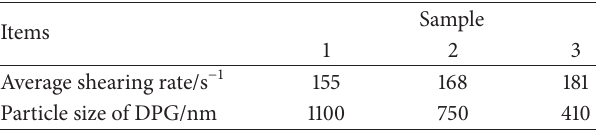
Table 2: Relationship between the particle size of the gel dispersion and the average shear